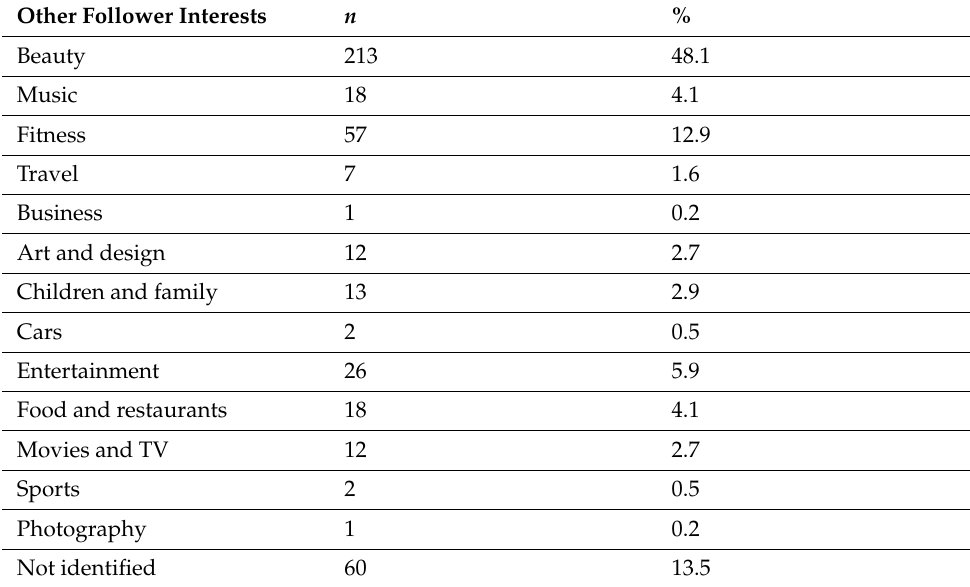
Table 2. Other interests of the followers analysed. Source: Own